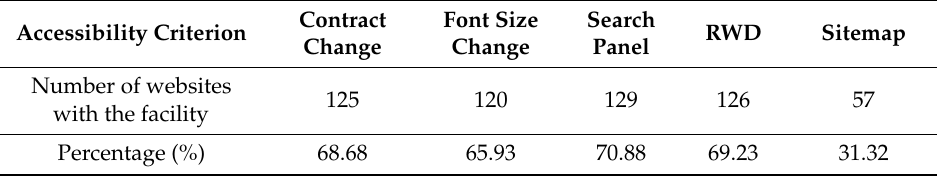
Table 4. Facilities for people with disabilities.